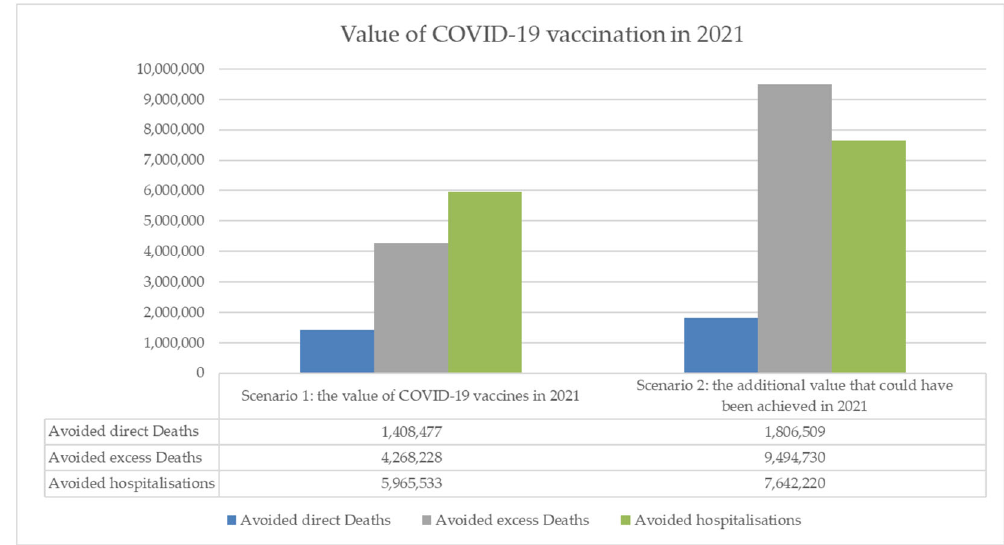
Figure 4. The value of vaccines in avoiding direct deaths, excess deaths, and hospitalisations in 2021. Table 6. Estimates of the value of vaccines including ranges based on +/ − 5 percentage point input values for vaccine efficacy.